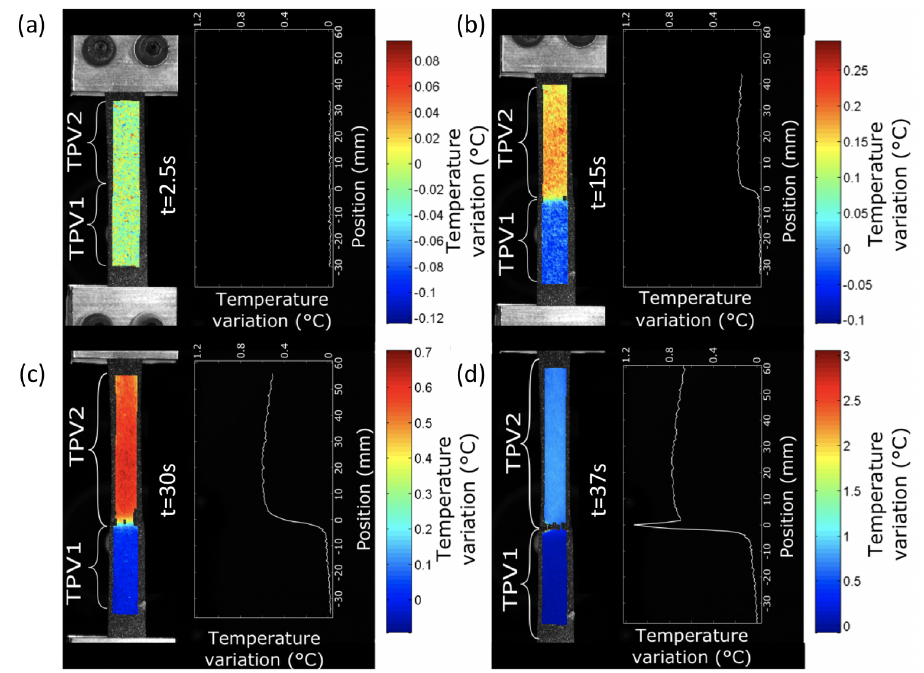
Figure 18. Temperature variation fields and the temperature variation profiles along the specimens overmoulded at 260 ◦ C. ( a ) t 1 = 2.5 s, ( b ) t 2 = 15 s, ( c ) t 3 = 30 s and ( d ) t 4 = 37